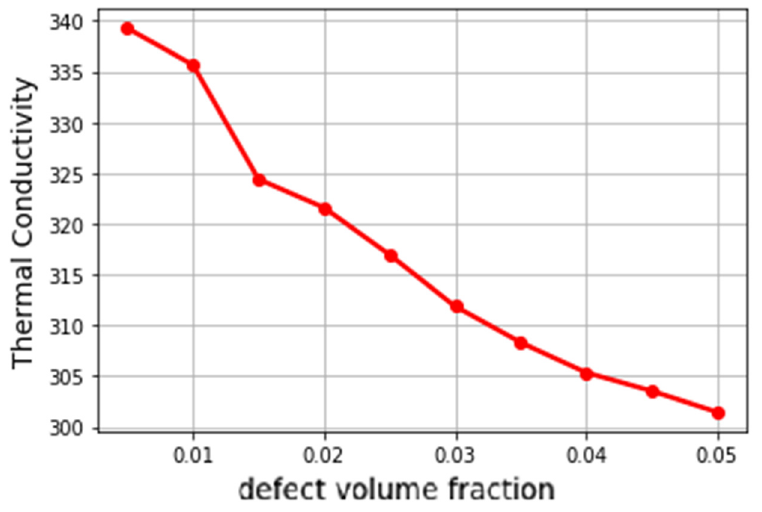
Figure 13. The effect of void percentage on the TC property in isotropic microstructures generated computationally.